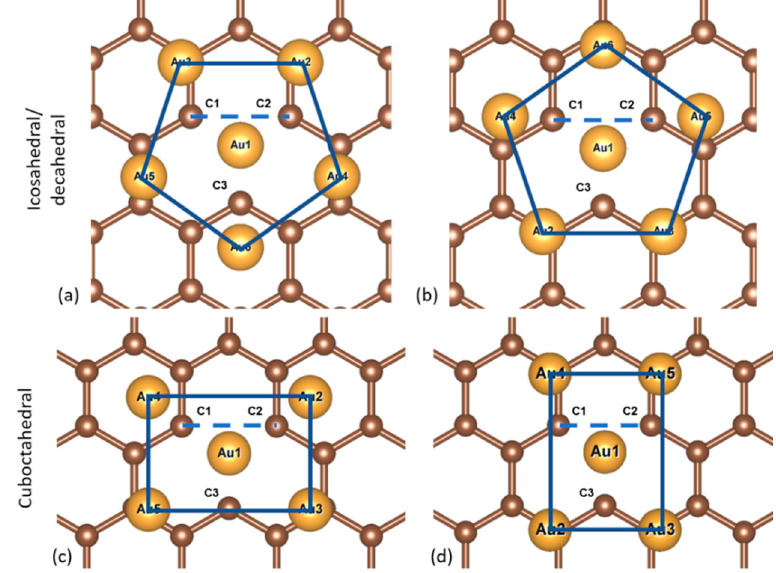
Figure 6. Cross-sections of the top-down views showing the first and second atom layers of the Au 561 NPs of of the three structural motifs in their different orientations on the graphene vacancy. First row: the vertices of the icosahedral and decahedral NPs with the tip of the pentagon pointing ( a ) towards the lone C3 atom and ( b ) away from it. Second row: the vertex of the cuboctahedral NP with the long edge of the rectangle ( c ) parallel and ( d ) anti-parallel to the bond of atoms C1 and C2.